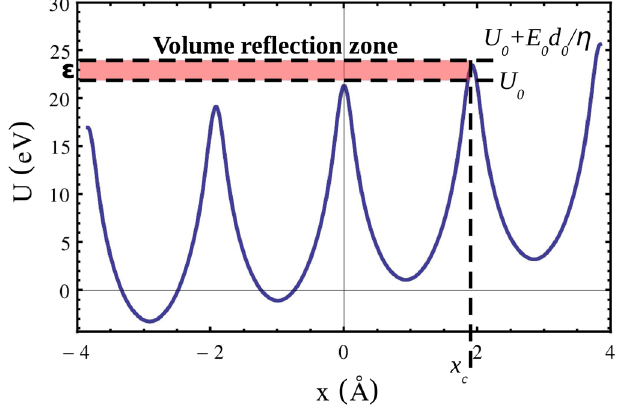
FIG. 3. The dependence of the ratio of volume reflection angle to the Lindhard angle on the ratio of the bending radius to its critical value.